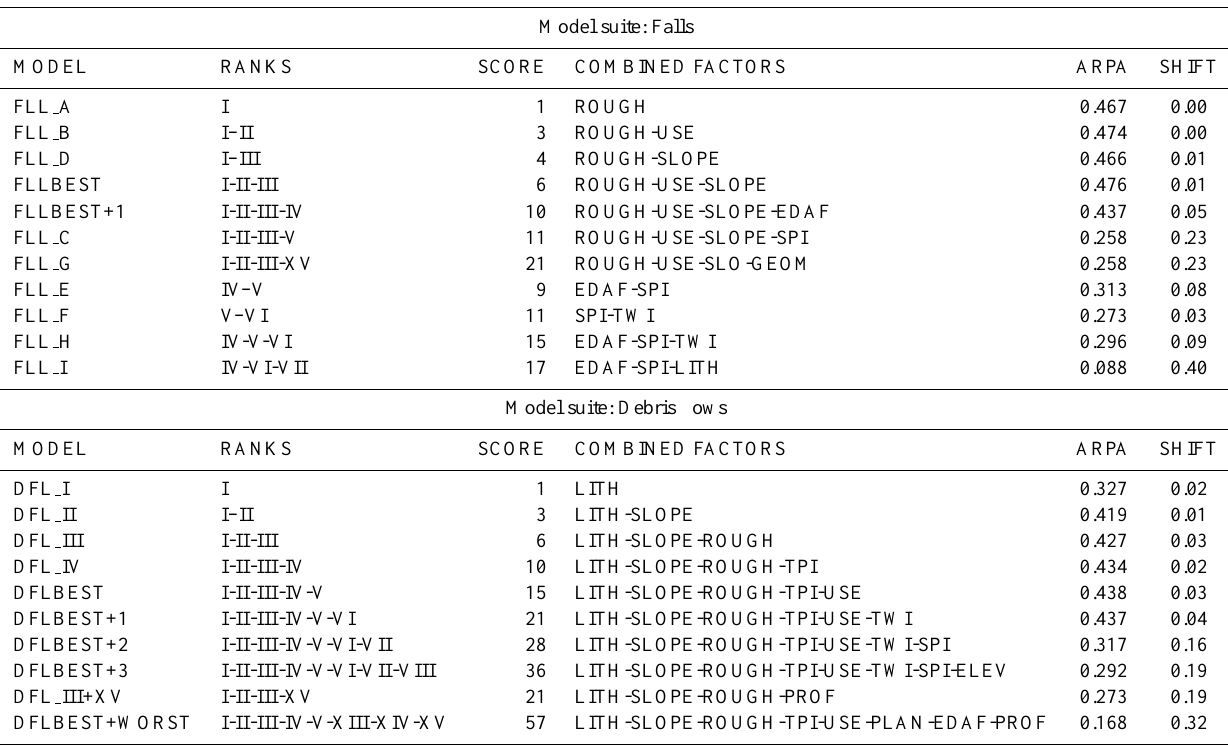
Table 4. The two suites of models allowed high coherence between the progressive addition of variables to the multivariate models and variation of ARPA; falls (a); debris flows (b).